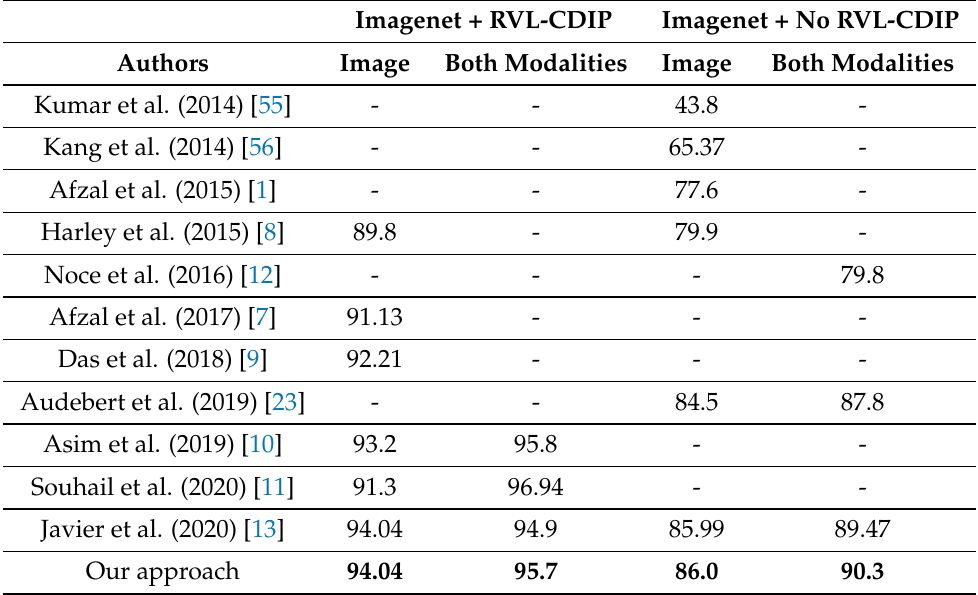
Table 1. Accuracy comparison of the proposed method to the former methods on Tobacco-3482 dataset. Our work surpasses all previous performance compared to only those approaches that do not train on the bigger dataset. We have highlighted best performing method in